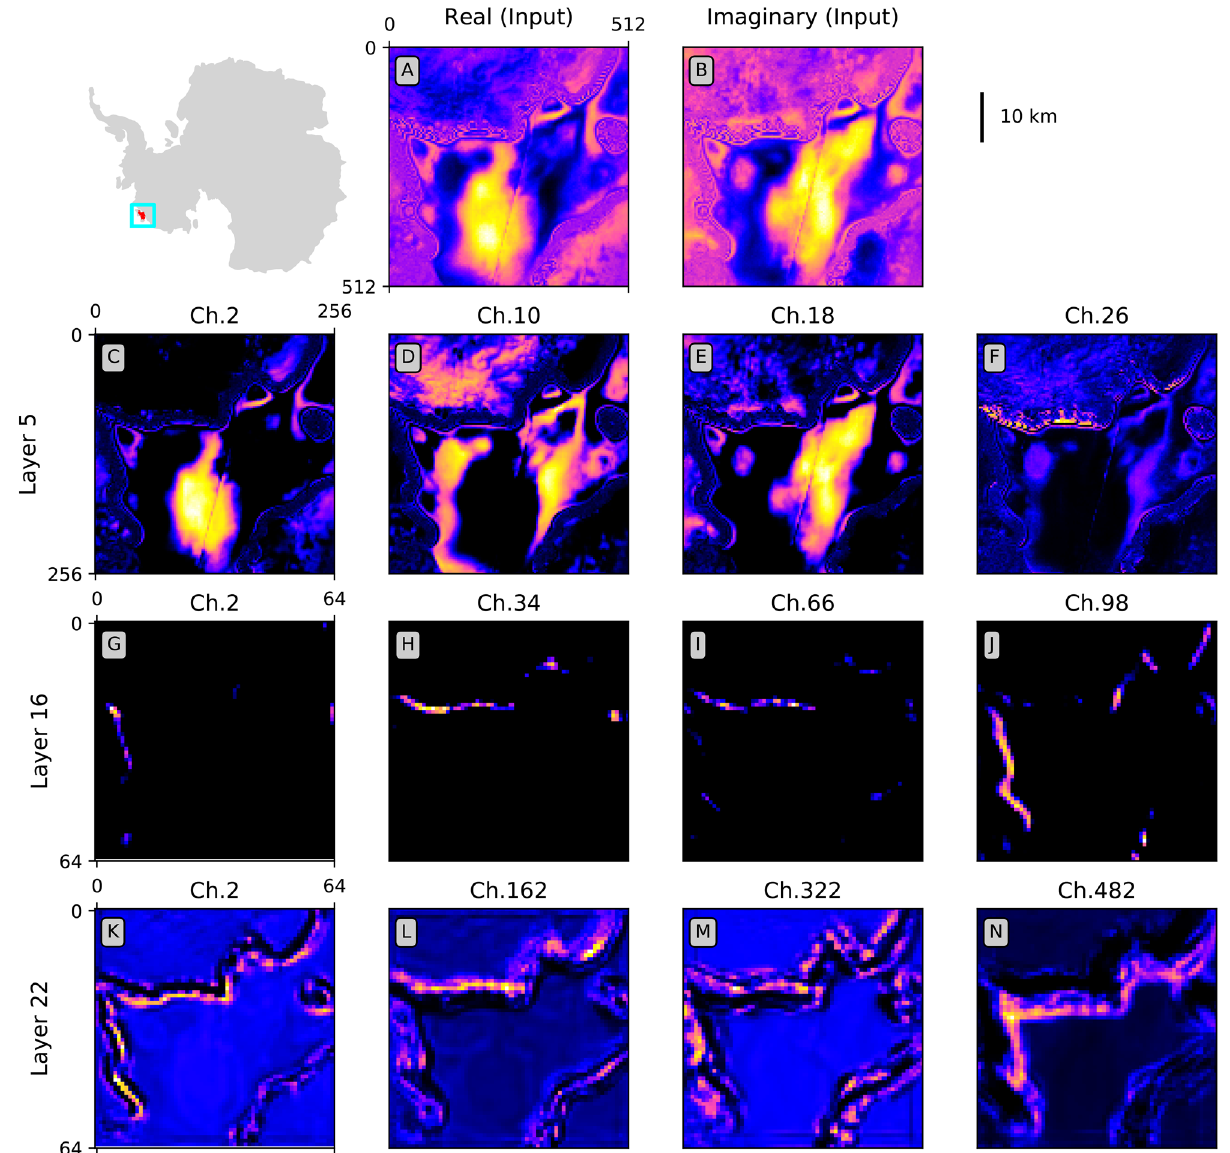
Figure 4. Activation Maps for the 1st (input), 5th, 16th, and 22nd layers. Note that magnitude of values in the intermediary layers before the final sigmoid layer depend on the choice of the activation function and do not have physical meaning. The numbers of channels represented are indicated on top of each plot. Note the decreasing image size as evident by the number of pixels shown on the axes. The location of the image is show on the upper left corner for text. The scalebar for the input is given on the upper right corner. The dilation rates for Layer 22 are 1, 2, 3, 4 for channels 22, 164, 322, and 482, respectively. The activation maps and the labels on the inset of Antarctica are plotted using Matplotlib version 3.3.2 19 . The Antarctic map is created using the default low resolution Earth map in Geopandas version 0.6.1 31 and plotted in Antarctic polar stereographic (EPSG:3031) projection. All libraries are used with Python 3.7.4 17